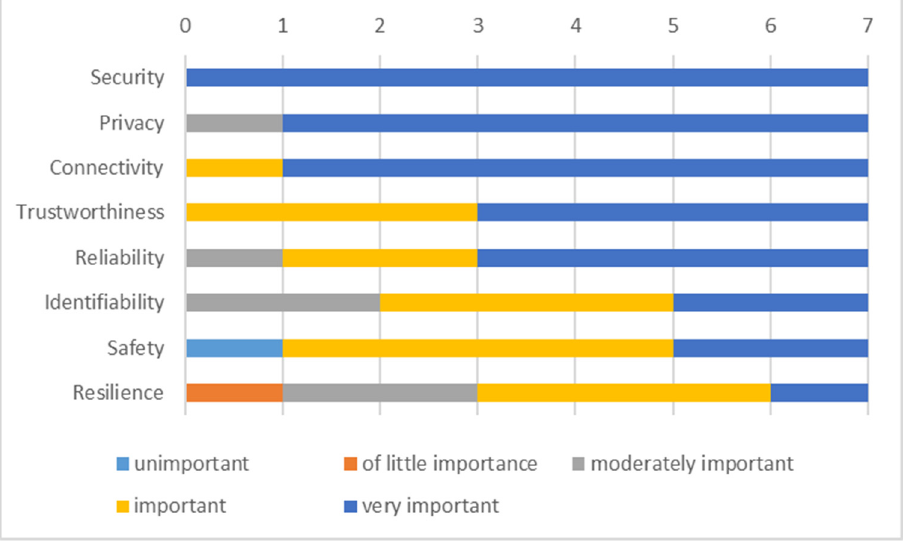
Figure 8. CREATE-IoT RAM cross-cutting functions-based classification summary.